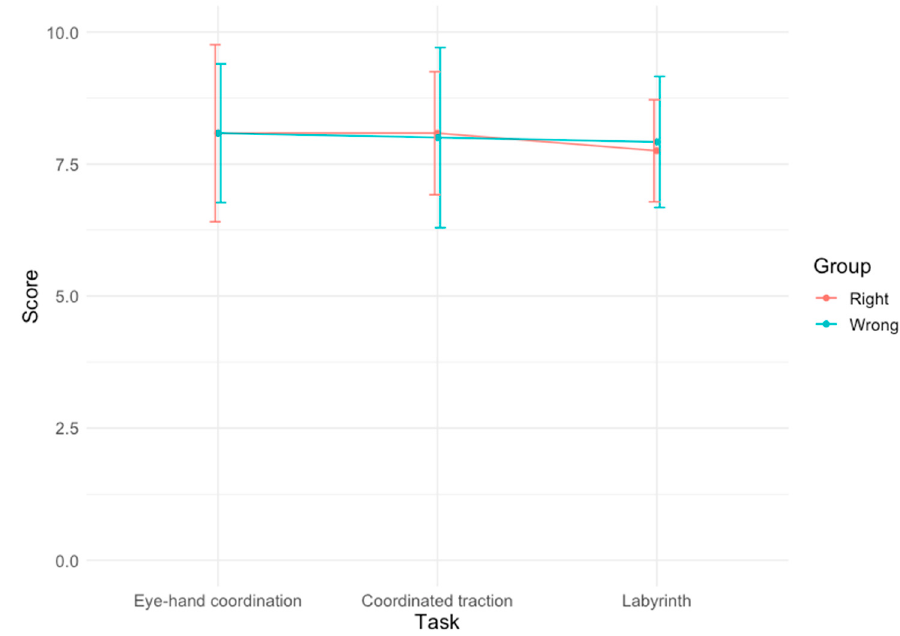
Figure 8. Flexion-extension of the surgeons’ wrist during the laparoscopic tasks using the right and wrong size of instrument handle. The graph indicates the acceptable posture of the wrist according to RULA method.